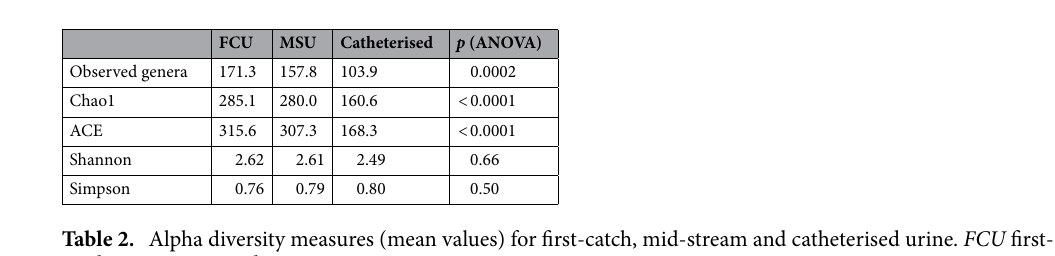
Figure 1. Barplots representing the relative abundance of OTUs in first-catch, mid-stream and catheterised urine samples, respectively, at genus level.